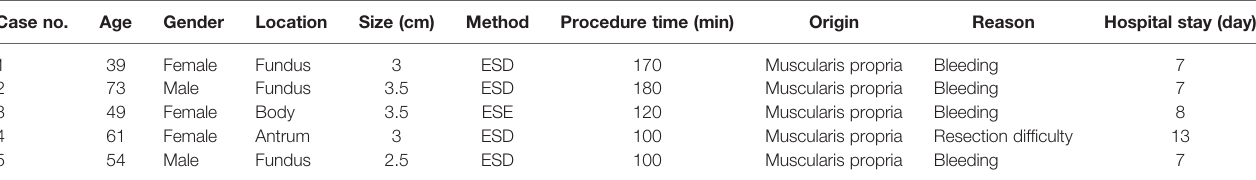
TABLE 2 | Clinical characteristics of patients who were converted to surgical resection. Case